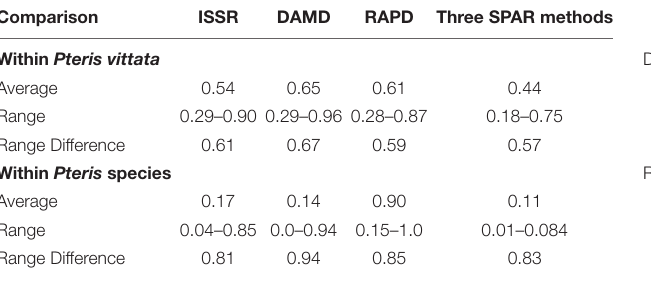
TABLE 3 | Comparison of the average similarity determined by three SPAR methods as well as primer-combination PCR, within P. vittata and other species in the species set.